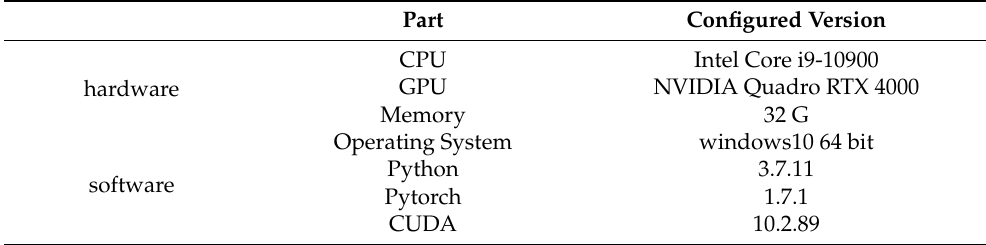
Table 1. Experimental environment description.